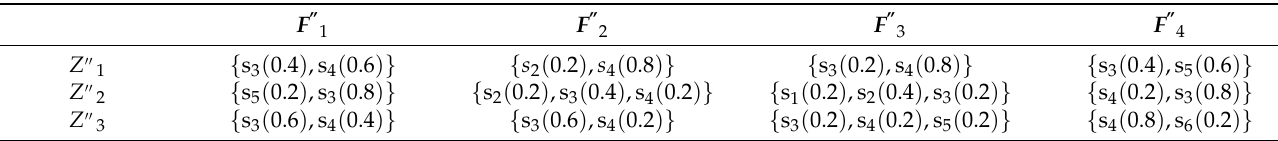
Table 4. Evaluation Information of Smart Hospital.